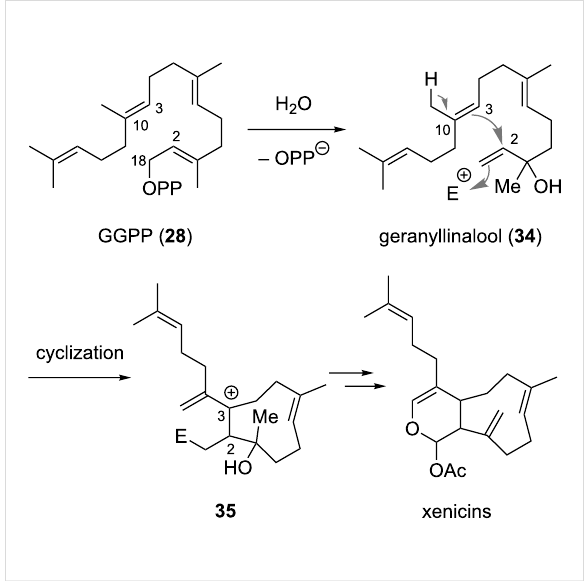
Scheme 2: Direct synthesis of the nine-membered carbocycle as proposed by Schmitz and van der Helm (E = electrophilic oxygen species)